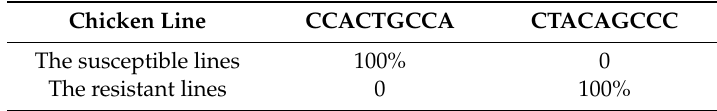
Table 6. Frequencies of 9 bp deletions in BF1 gene in lines of chickens selected for resistance to Marek’s